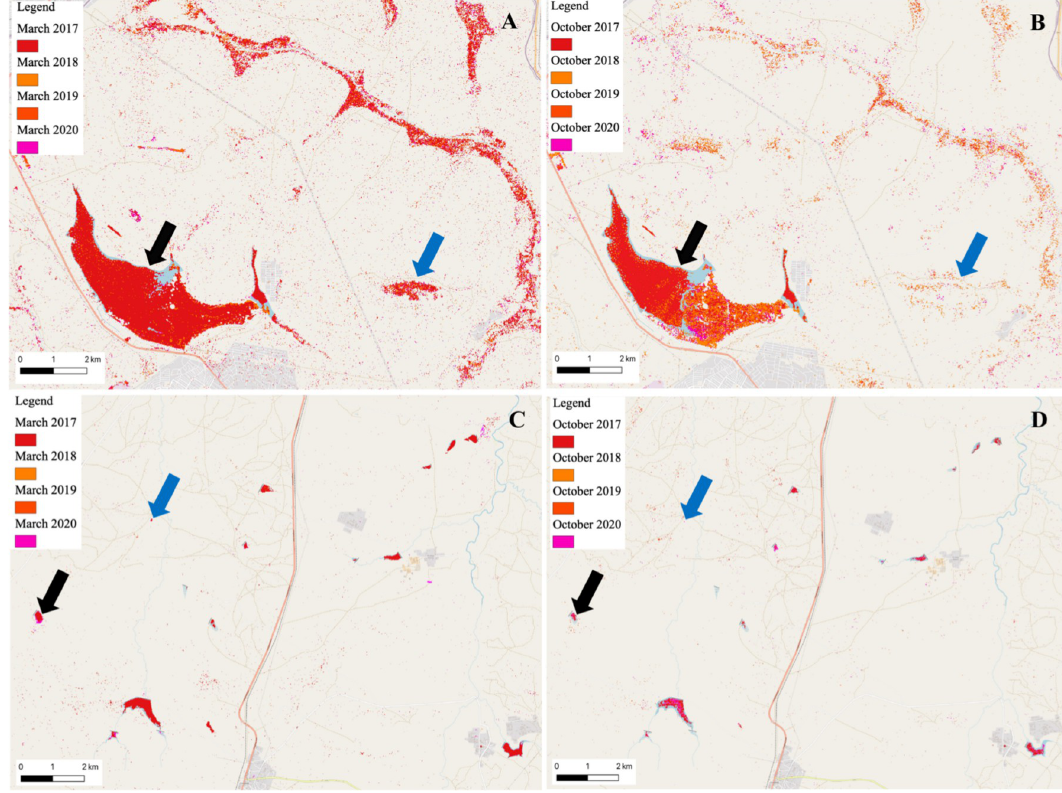
Fig 8. Permanent and ephemeral water bodies in Chililabombwe and Monze districts. Waterbodies were mapped as cumulative totals for March and October for the period 2017–2020. (A & B) Dambos in the Wet (March) and Dry Season (October) in Chililabombwe District on the Copperbelt Province. (C & D) Dambos in the wet (March) and dry (October) season in Monze District in Southern Province. Black and Blue arrows indicate permanent and ephemeral water bodies, respectively. Base map republished from OpenStreetMap (https://www.openstreetmap.org/copyright) under a CC BY